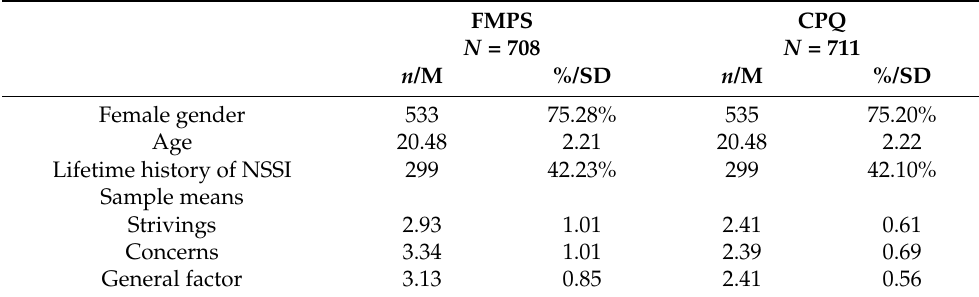
Table 1. Demographic Information across the